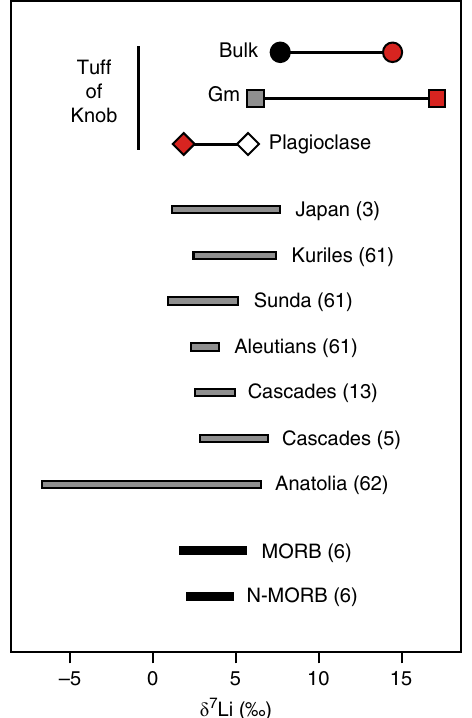
Fig. 7 Variability in δ 7 Li in the Tuff of Knob compared to previous regional studies. Sources of Li isotopic data are marked with respective